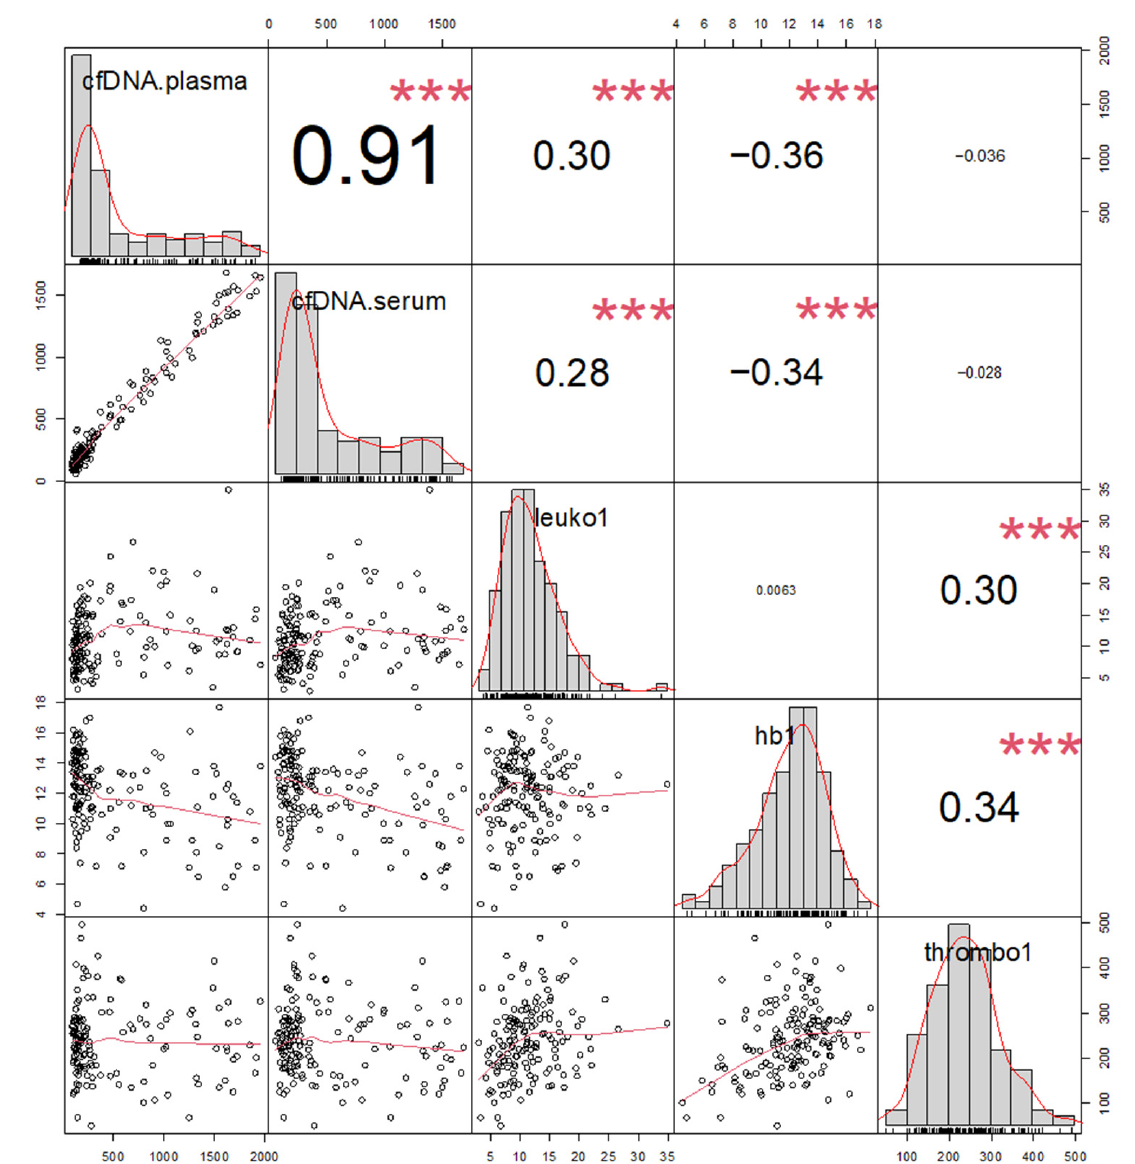
Figure 3. Correlation plots (graphics, lower left part) with corresponding correlation coefficients (numbers, upper right part) and value distribution of the markers (diagonal) for cfDNA in plasma and serum and hematology parameters leukocytes (Leuko1), hemoglobin (hb1), and platelets (thrombo1) for all patients. *** ( p ≤ 0.001).